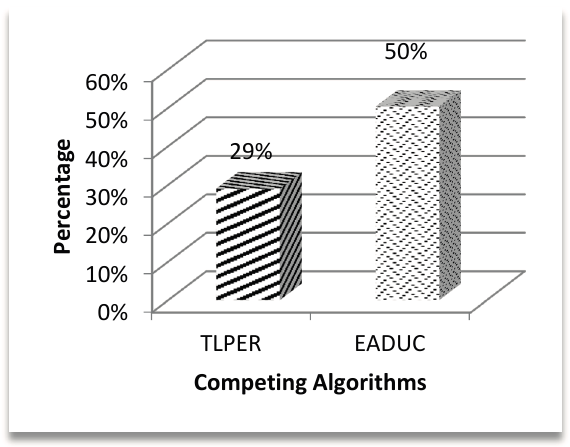
Figure 7. Performance efficiency of EAR4MCDA over competing algorithms in total energy consumption.